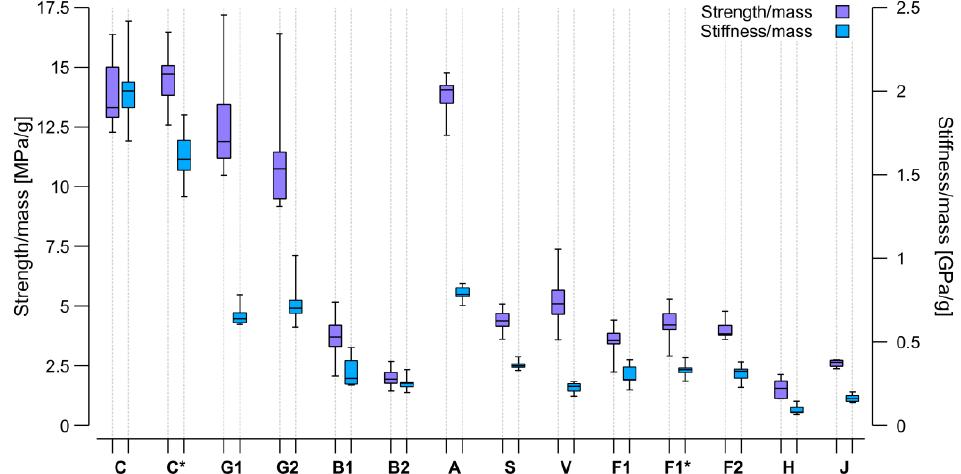
Figure 14. Comparison of the strength and stiffness per mass of each sample type. Axes are differently scaled. The whiskers of the boxplots represent the min/max range. C—carbon, C*—carbon